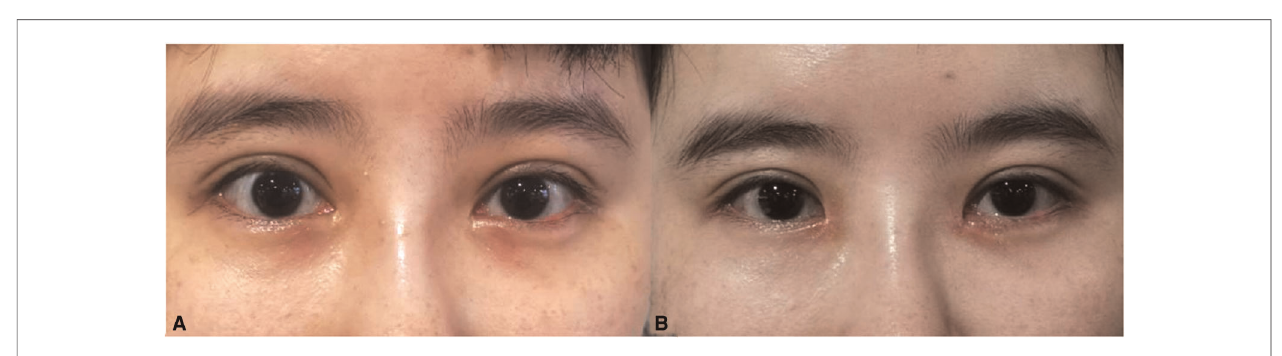
FIGURE 6 | Case 2 ( A ) Before surgery and ( B ) Six months after surgery.